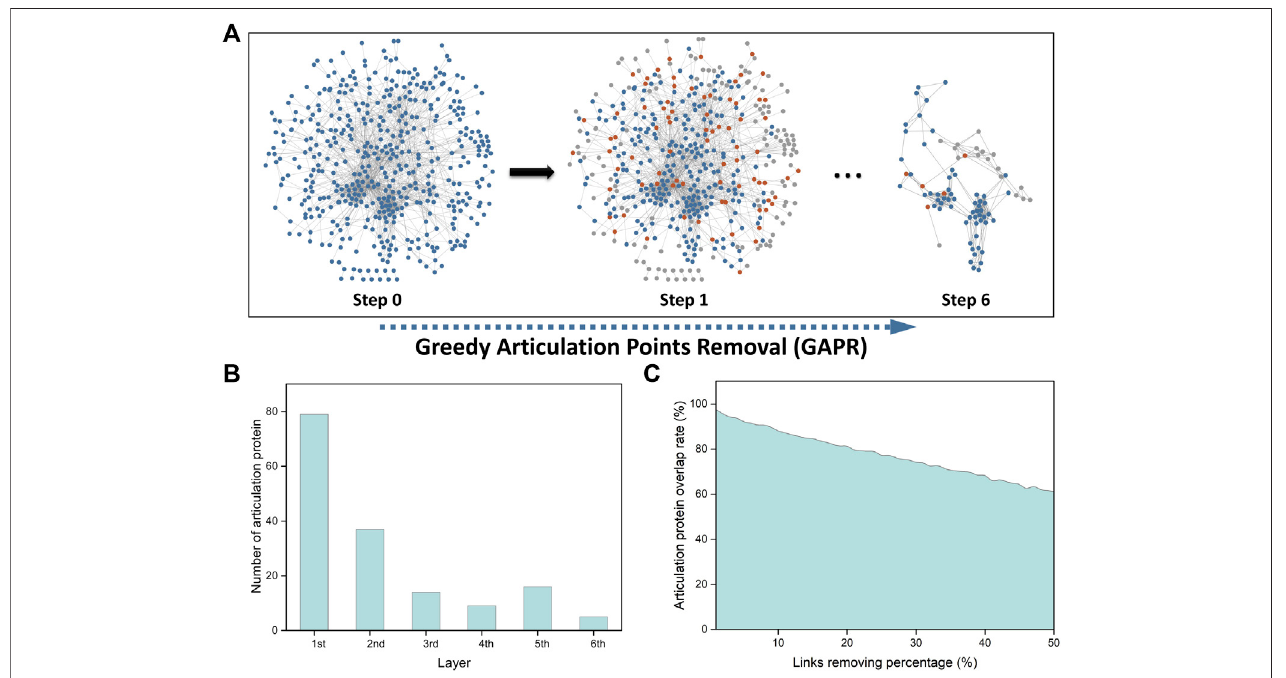
FIGURE 4 | Network analysis of important transcriptomic features using greedy articulation point removal (GAPR) method. (A) Construction of the vitiligo PPI subnetwork (VitNet) and the GAPR method process. Blue nodes represented important transcriptomic features. Orange nodes represented articulation points. Grey nodes represented supporting points. (B) The number of articulation protein in the initial and deep network. (C) Robustness analysis of the GAPR method.